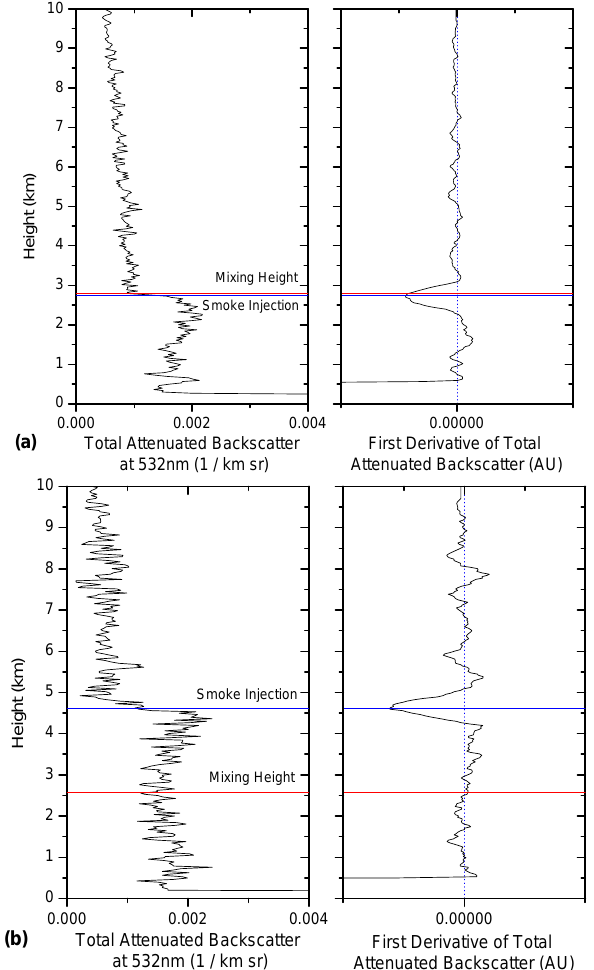
Fig. 3. Examples of CALIPSO Level-1 attenuated backscatter pro- files at 532nm and the corresponding injection heights (blue lines) calculated with the slope method (left panels) and the profiles of the corresponding first derivative of the attenuated backscatter co- efficient (right panels) at 15 August 2006 (upper panels) and 16 August 2008 (lower panels). The ECMWF mixing heights are su- perimposed (red lines) to demonstrate that the smoke can lie within PBL (Fig. 3a), but also penetrate to the free troposphere (Fig.